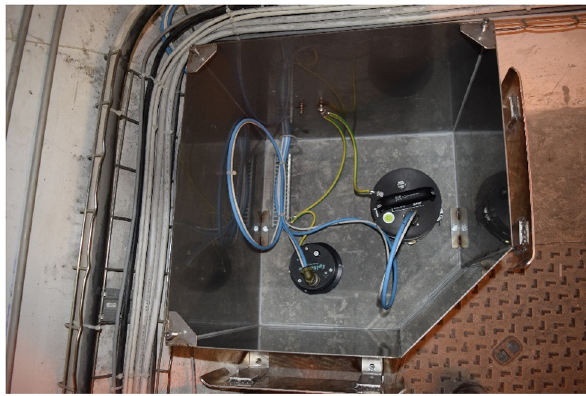
Figure 2: Vibrometers placed inside the Point 5 seismic station: strong motion sensor ( left ) and broadband sensor ( right ) .